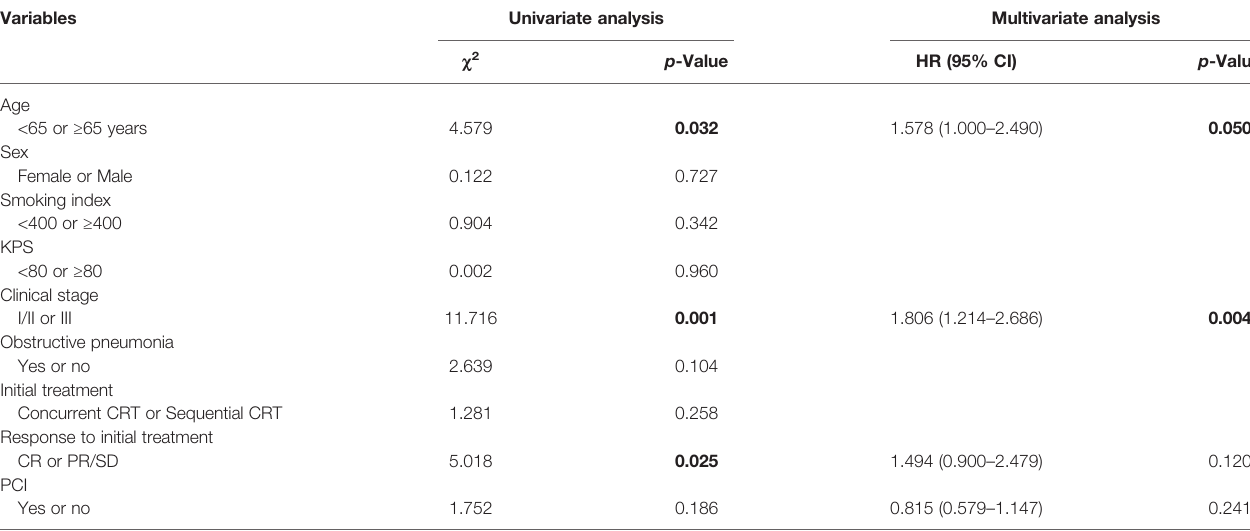
TABLE 4 | Univariate and multivariate analyses of factors in fl uencing PFS, after propensity score